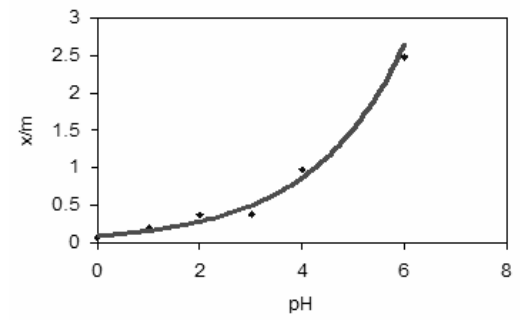
Figure 10 . Effect of pH on lead sorption by PANi/SD